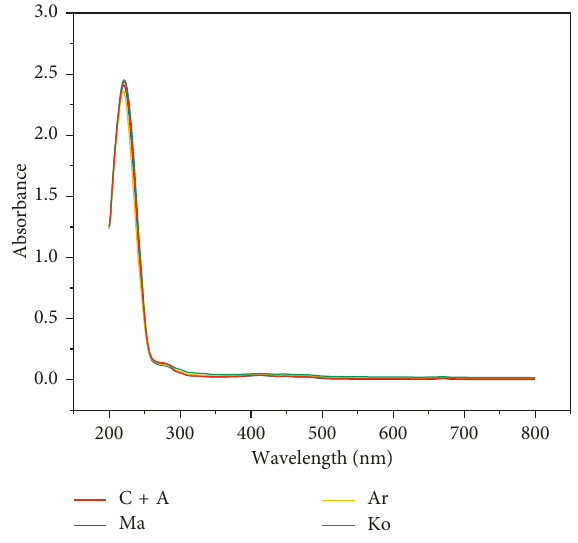
Figure 4: UV spectra for the four olive oil varieties studied. Table 5: K 232 and K 270 values of the analyzed EVOO samples. K 232 K